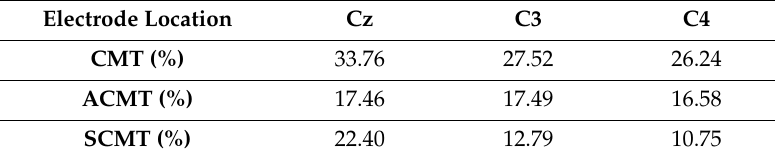
Table 4. Standard deviations of relative power spectral density